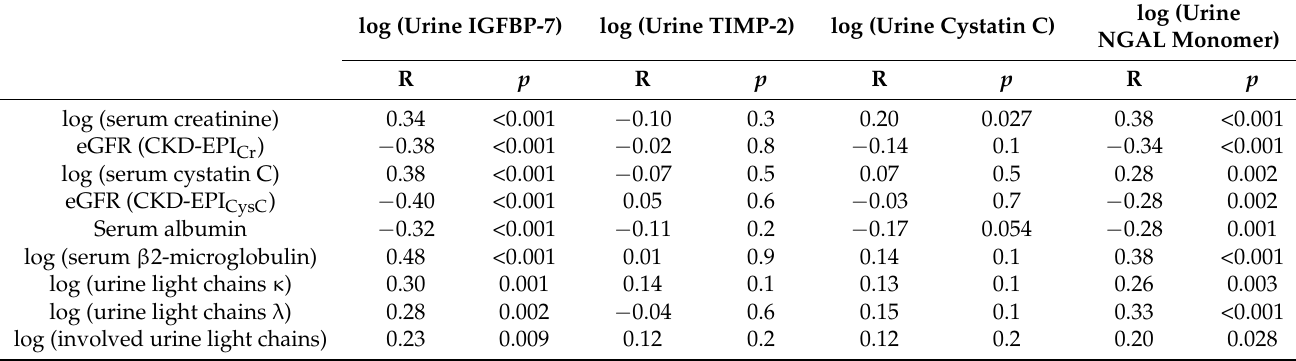
Abbreviations: CKD-EPICr, Chronic Kidney Disease Epidemiology Collaboration equation based on serum creatinine; CKD-EPICysC, Chronic Kidney Disease Epidemiology Collaboration equation based on serum cystatin C; eGFR, estimated glomerular filtration rate; IGFBP-7, insulin-like growth factor-binding protein 7; NGAL, neutrophil gelatinase-associated lipocalin; TIMP-2, tissue inhibitor of matrix metalloproteinase